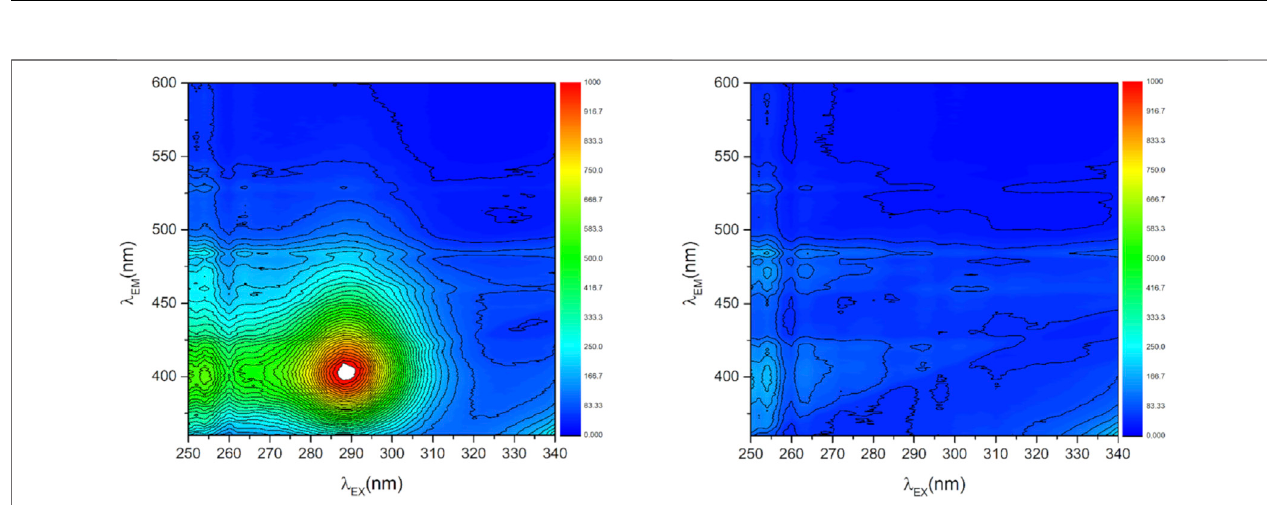
FIGURE 4 | 2D photoluminescence spectra of Mn doped CaO (0.17 atom% Mn) in vacuum ( p < 5*10 − 6 mbar, left) and exposed to 1 mbar O 2 (right).